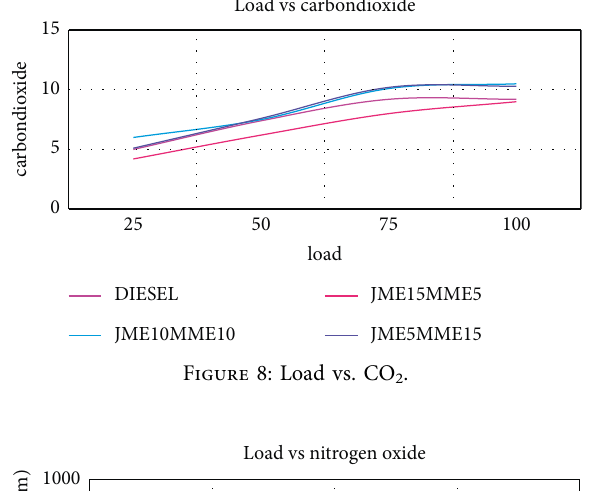
Figure 5: BSFC vs.